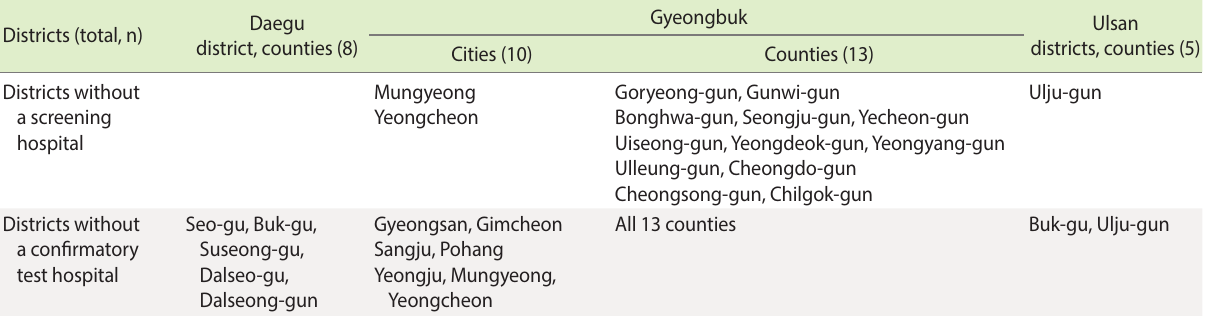
Table 4. Geographical distribution of hospitals designated for hearing tests in Daegu, Gyeongbuk, and Ulsan (2016) Districts (total,